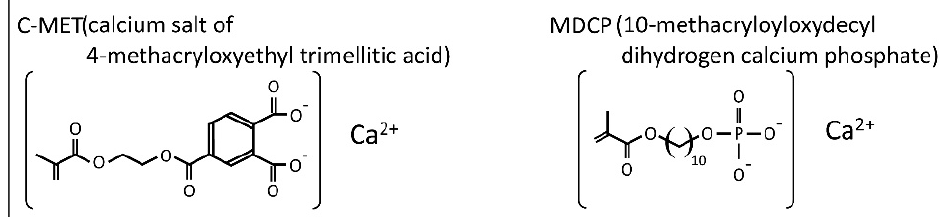
Figure 1. Chemical formulas of new adhesive monomers C-MET and MDCP.